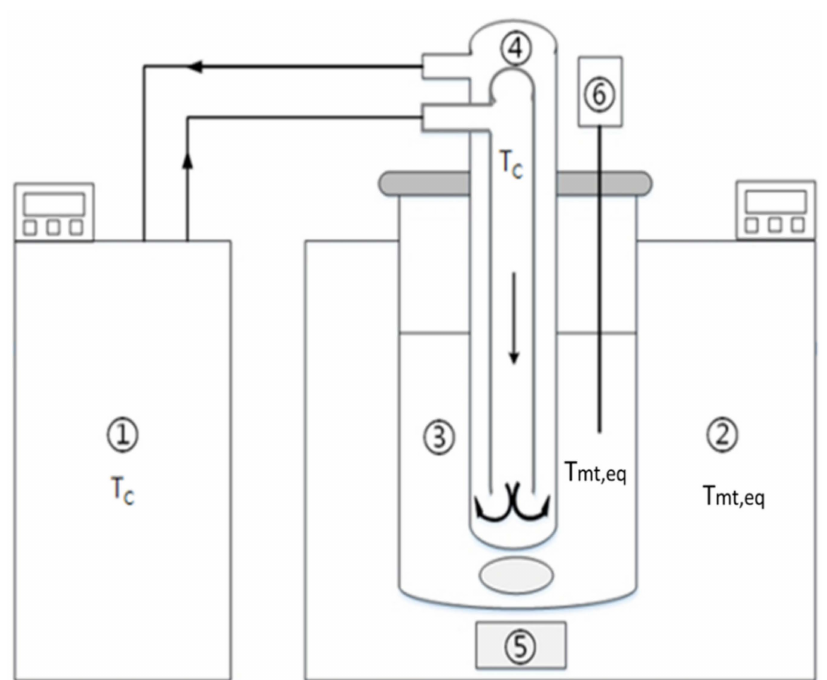
Figure 1. Schematic diagram of the experimental apparatus [22]: (1) water bath for the cylindrical crystallizer; (2) water bath for the vessel; (3) melt; (4) cylindrical crystallizer with coolant inlet and outlet; (5) magnetic stirrer; (6) temperature probe.